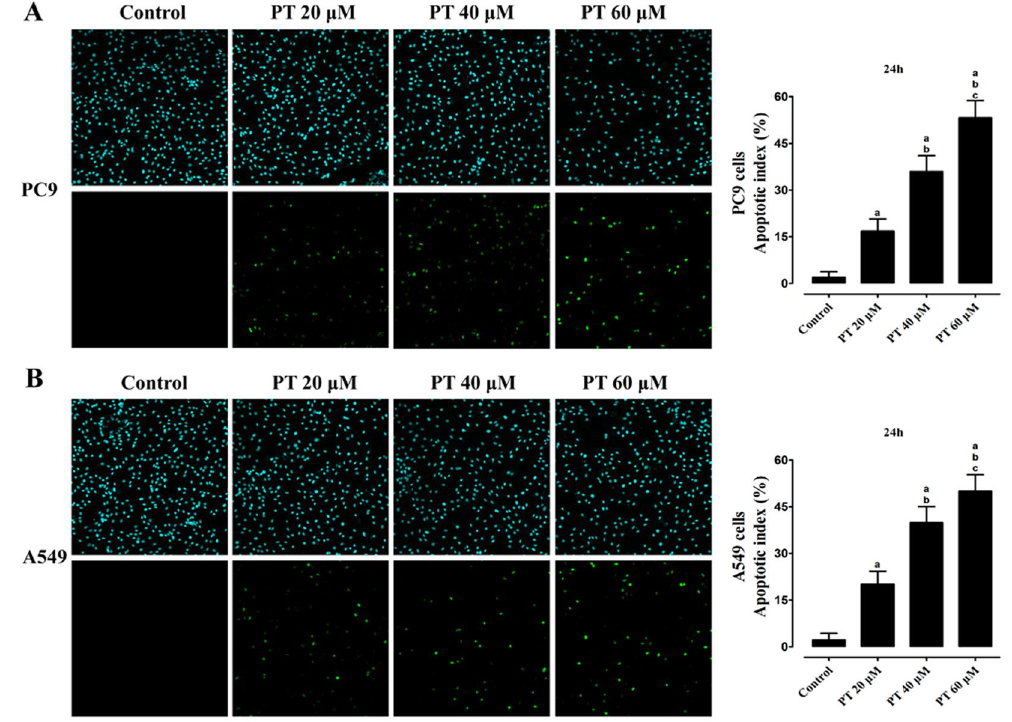
Figure 2. Effect of PT treatment on the apoptosis of PC9 and A549 cells (24 h). After treatment on both cell lines ( A for PC9, B for A549), the apoptotic index of PT-treated groups exerted a dose-dependent increase in induction of apoptosis. The upper panel showed the cell nucleus ( blue ) and the lower panel displayed the apoptotic cells ( green ). All of the results were expressed as the mean ± SD; n = 6. a P < 0.05 vs . the control group, b P < 0.05 vs . the 20 μ M PT-treated group, c P < 0.05 vs . the 40 μ M PT-treated